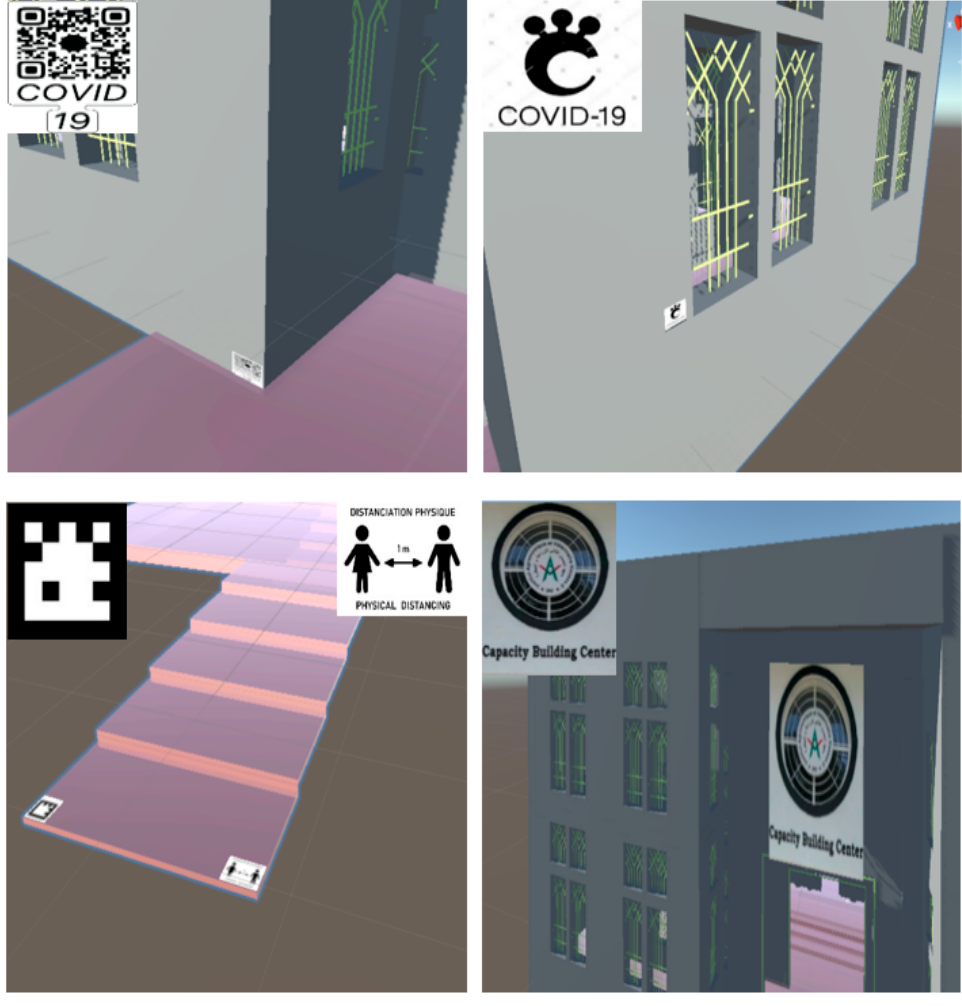
Figure 9. Types of markers used outdoors.